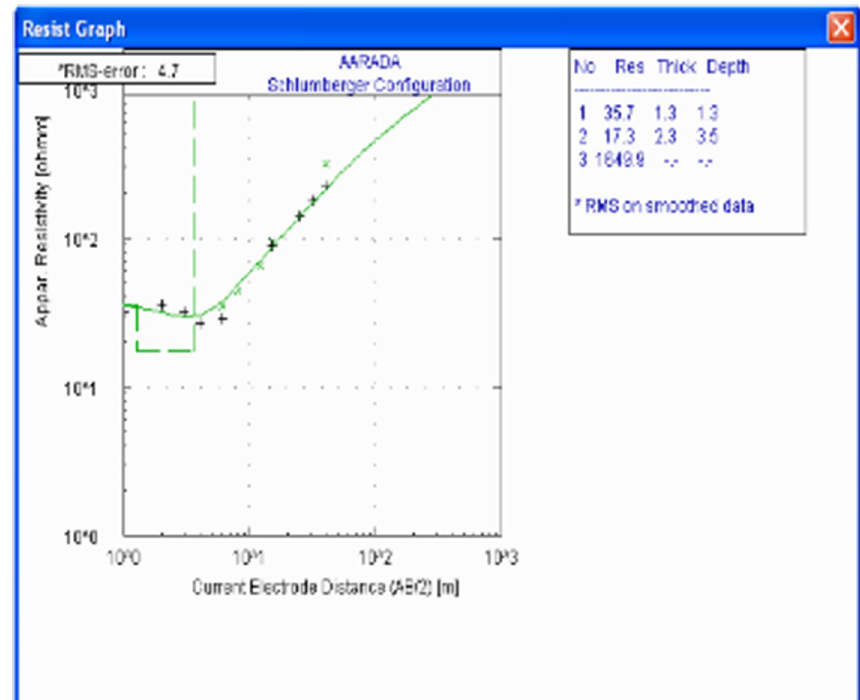
Fig. 1 Modeled Curve of a VES, Olafisoye et al., (2013)